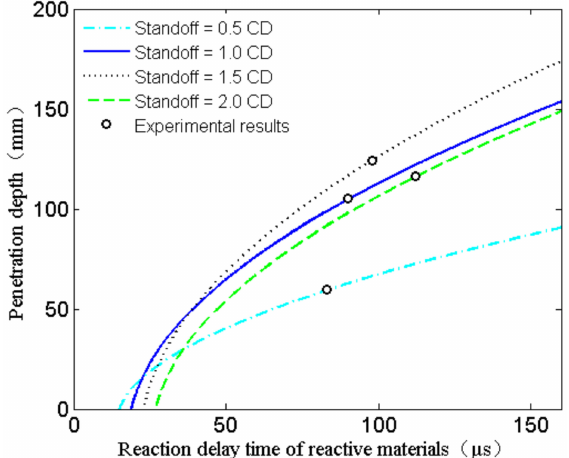
Figure 13. Reaction delay time and stando ff a ff ecting the penetration